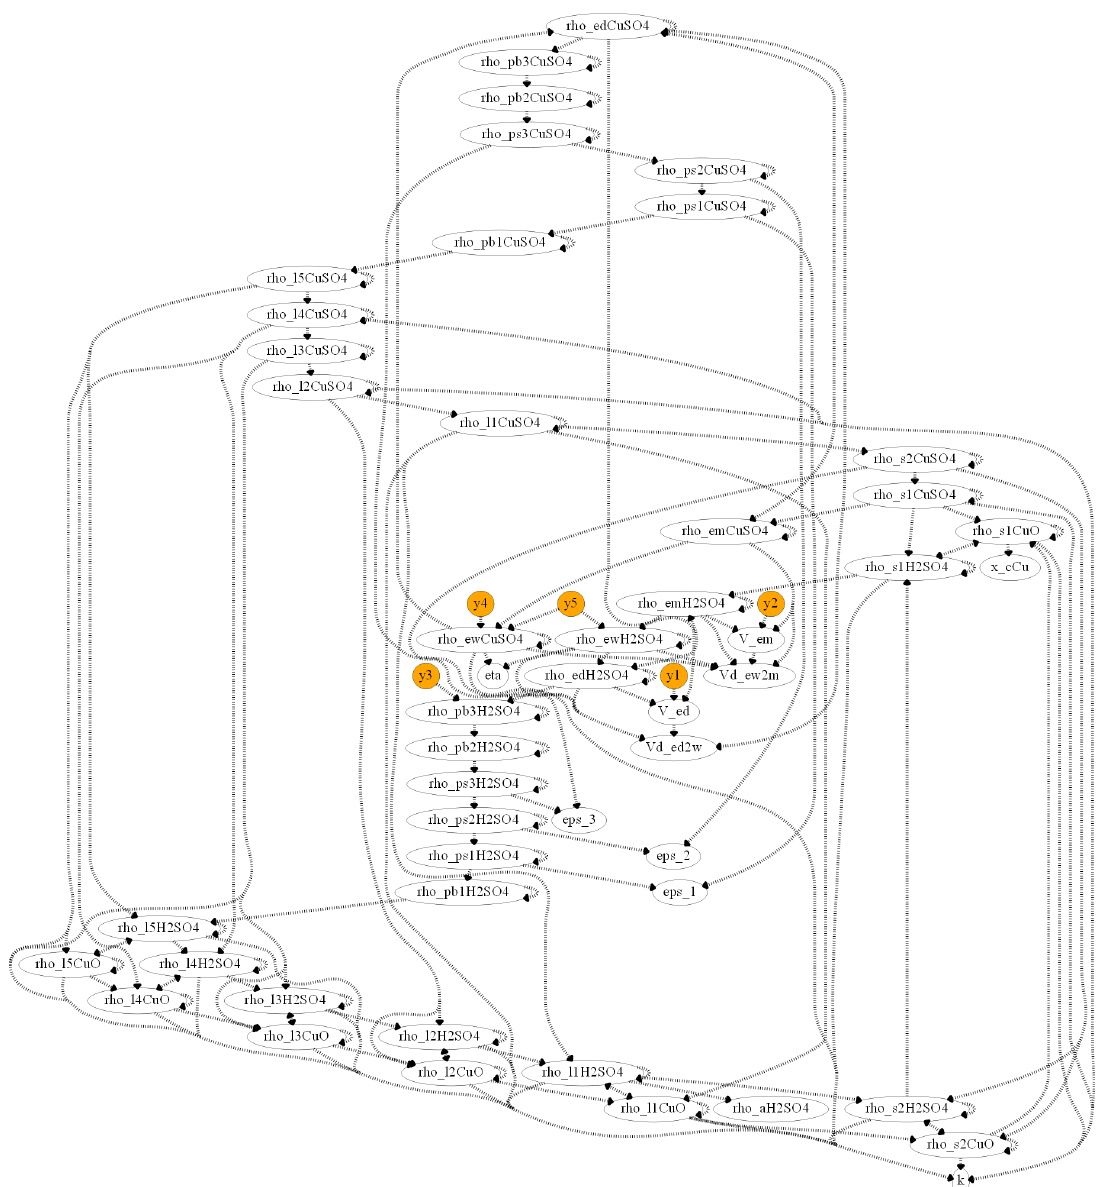
Figure 8: The digraph ( G ) for the Copper plant